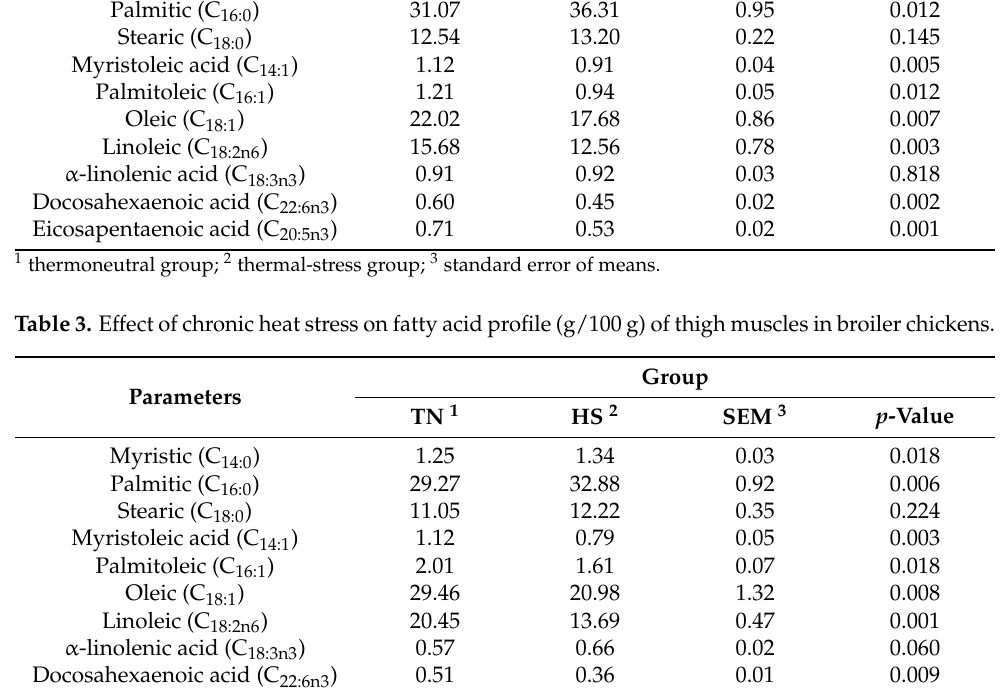
Table 2. Effect of chronic heat stress on fatty acid profile (g/100 g) of breast muscles in broiler chickens. Parameters